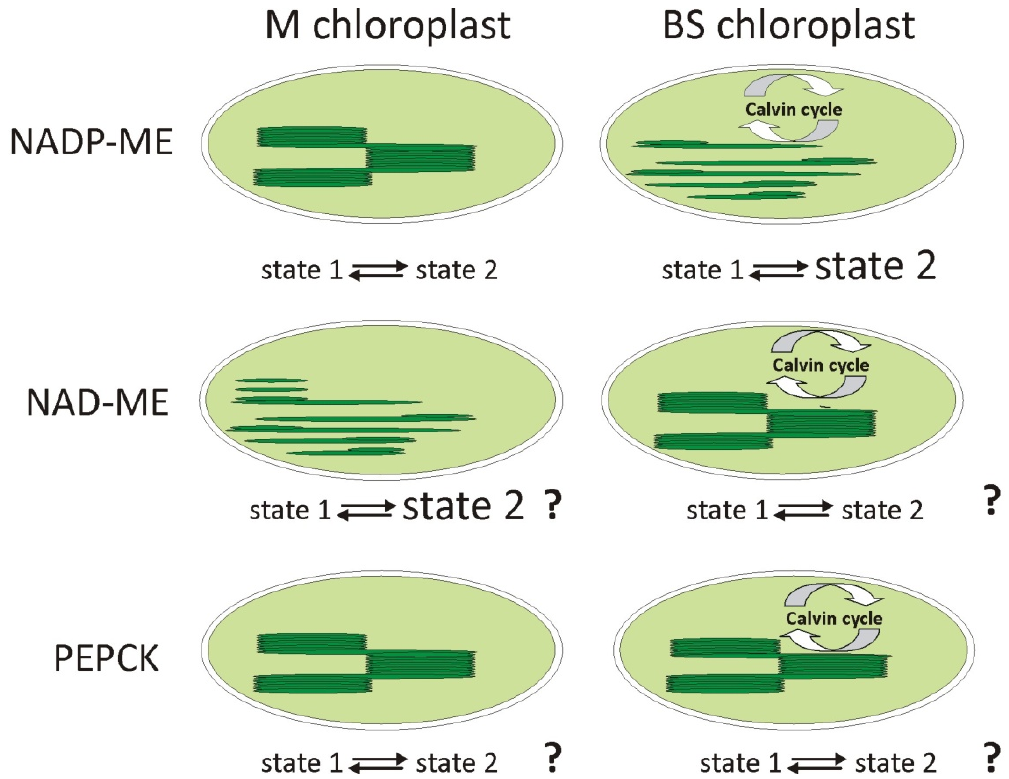
Figure 5. Models of state 1 state 2 transitions in two types of chloroplasts in three subtypes of C4 plants. In maize (NADP-ME) mesophyll chloroplasts, the typical transition from state 1 to state 2 occurs, while in bundle sheath chloroplasts it is permanent state 2 where some pool of LHCII antennas are bound to PSI [41]. For the NAD-ME and PEPCK subtypes, in which the regulation of antenna migration is unknown, the shown model of state transitions is based on the organization of thylakoid membranes and the demand for ATP.